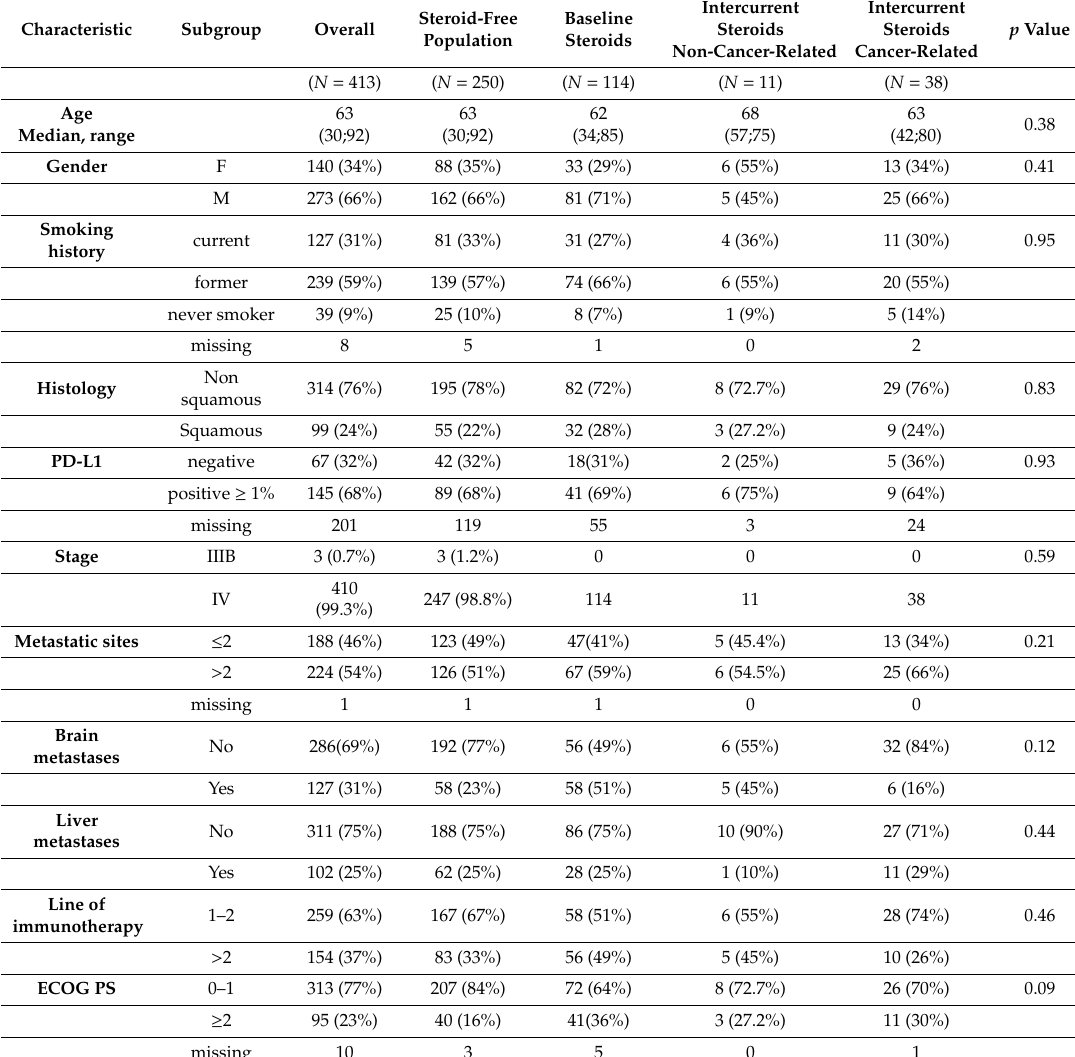
Table 1. Baseline characteristics of the study